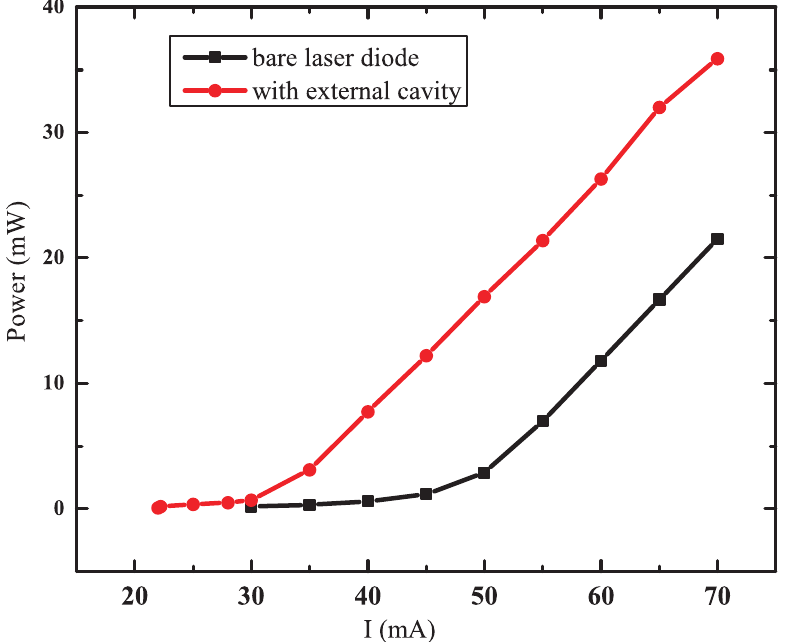
Figure 7. Output power versus laser diode current as measured using an optical powermeter at a controlled laser temperature of 22.3 ◦